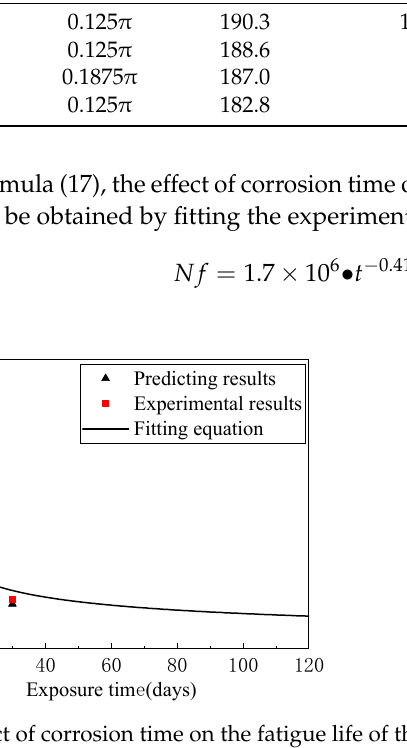
Figure 13. The effect of corrosion time on the fatigue life of the 5083/6005A welded joints.